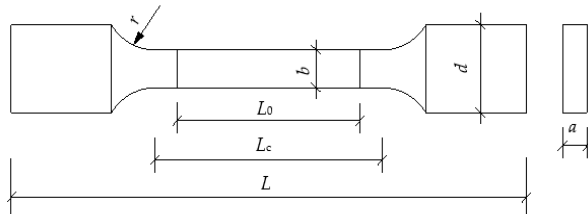
Figure 5. Fabricated coupon.